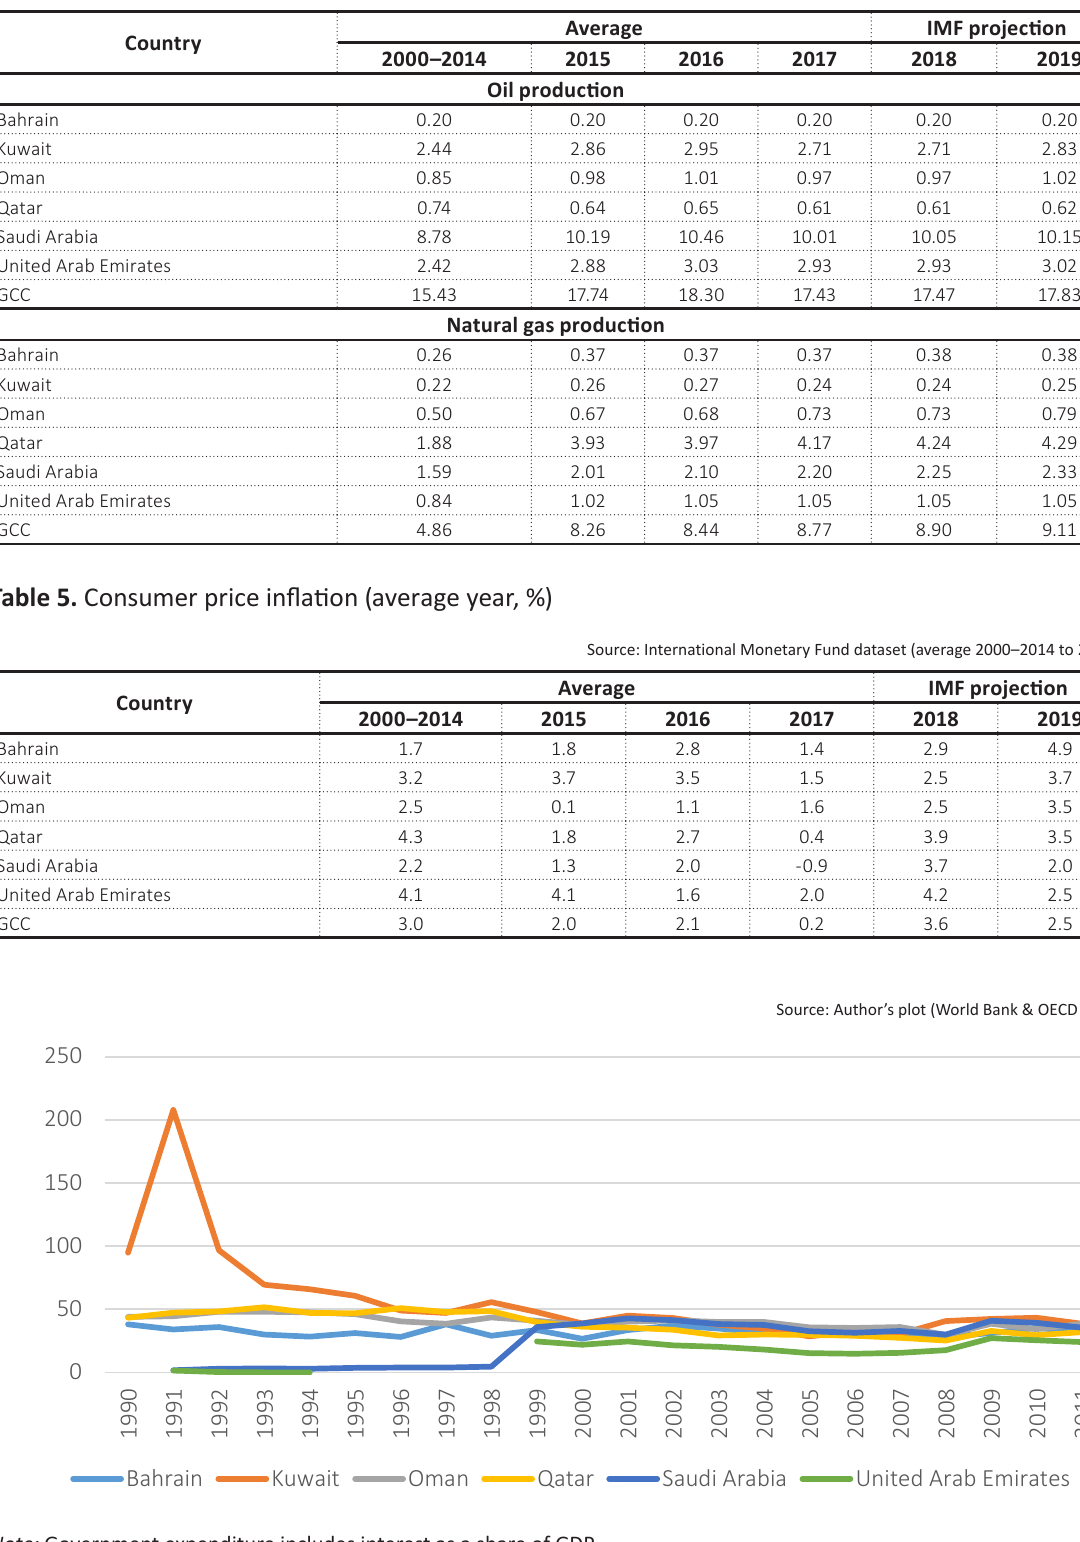
Table 4. Oil and natural gas production (million barrels/day) Source: International Monetary Fund dataset (average 2000–2014 to 2019).